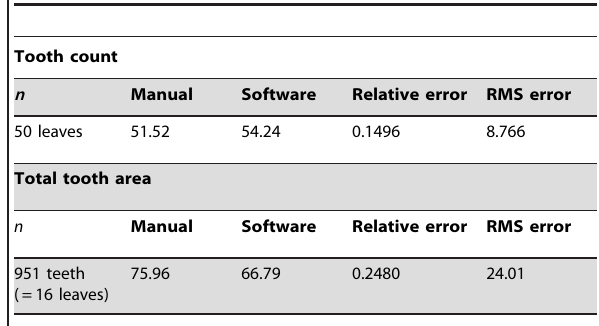
Table 3. Summary of